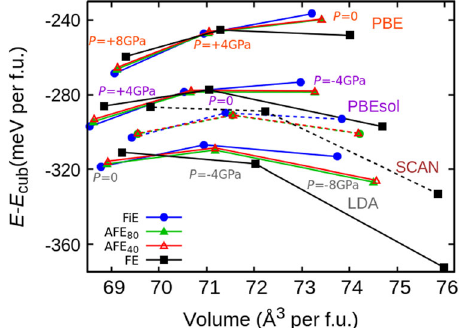
Fig. 3 Kohn – Sham energies as a function of volume per formula unit for the PbZrO 3 polymorphs at different pressures and with different exchange-correlation functionals. LDA results for 0, − 4 and − 8 GPa are displayed (bottom). PBEsol and SCAN results shown for + 4, 0 and − 4 GPa (centre, solid and dashed lines, respectively). PBE results for + 8, + 4 and 0 GPa shown (top). The energies are shown relative to the energy of the cubic phase for each pressure. Blue circles, red empty triangles, green fi lled triangles, and black squares correspond to the FiE, AFE 40 , AFE 80 and FE phases, respectively. The results for SCAN are shifted by + 20 meV per f.u. for clarity. In the used convention, a positive external pressure implies a